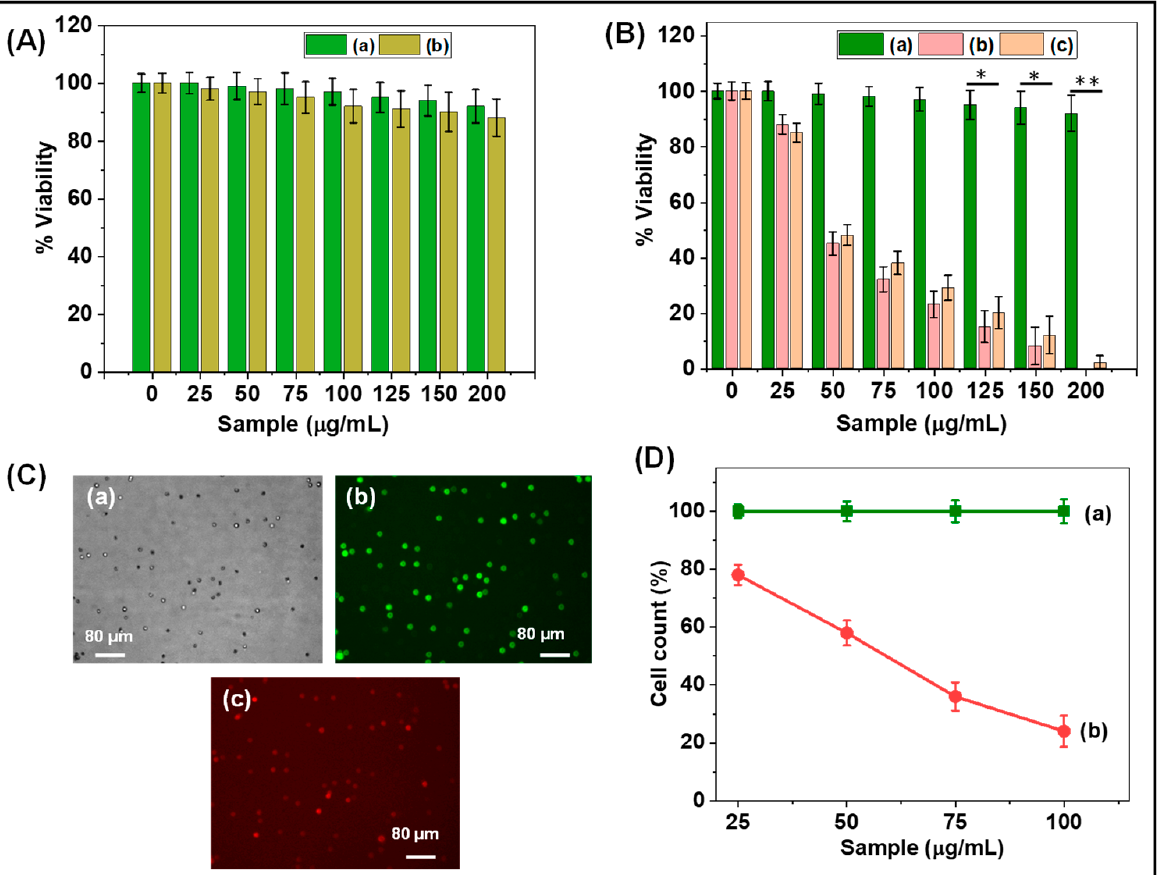
Figure 6. ( A ) In vitro cytocompatibility of ( a ) control HepG2 cells and ( b ) PNIPAm-co-PAAm copolymer; ( B ) In vitro cytocompatibility of ( a )PNIPAm-co-PAAm-Mela HG; ( b ) PNIPAm-co-PAAm- Mela/Cur HG; and ( c ) pure Cur drug, respectively, at different concentrations. Statistical significance to the cell toxicity with different samples (*, significant p < 0.05; **, highly significant p < 0.01). ( C ) Fluorescence microscopy images of HepG2 cells represent ( a ) dark-field image; ( b ) PNIPAm- co-PAAm-Mela HG treated cells; and ( c ) Cur loaded PNIPAm-co-PAAm-Mela/Cur HG system, respectively. ( D ) Cell viability of ( a ) PNIPAm-co-PAAm-Mela HG treated cells; and ( b ) Cur loaded PNIPAm-co-PAAm-Mela/Cur HG system, respectively, at different sample concentrations. Mean with error bar n =